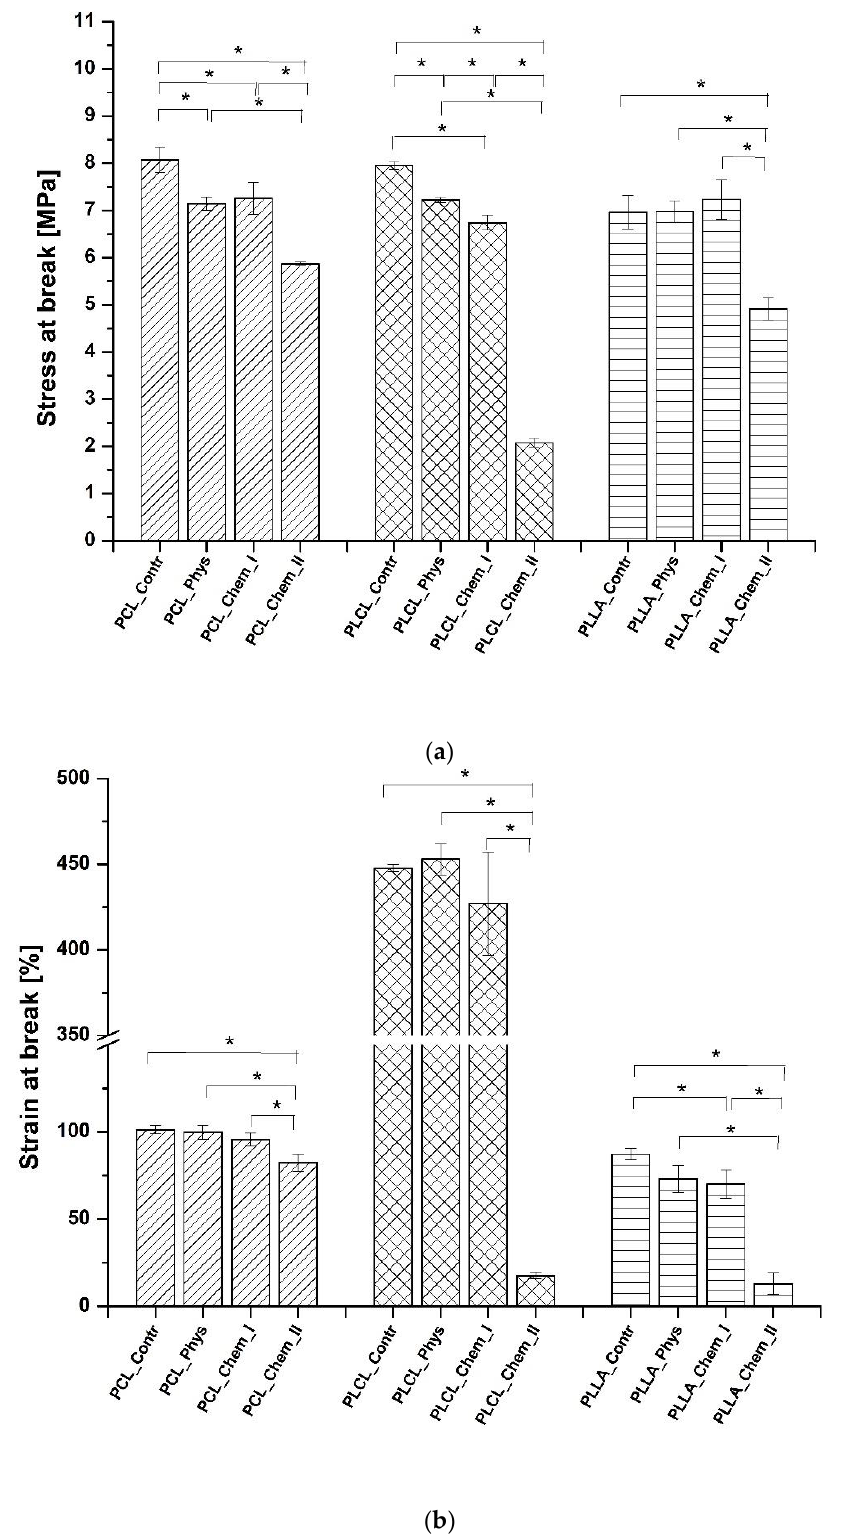
Figure 6. Mechanical properties: ( a ) stress at break, and ( b ) strain at break of control and gelatin- coated fibers. Statistically significant differences were marked as * (p < 0.05) Similar correlation was observed in the case of a strain at break. Only a slight decrease or no change in the strain at break was observed in the case of all samples with phy- sisorbed gelatin or those that were mildly modified via aminolysis. The high decrease was